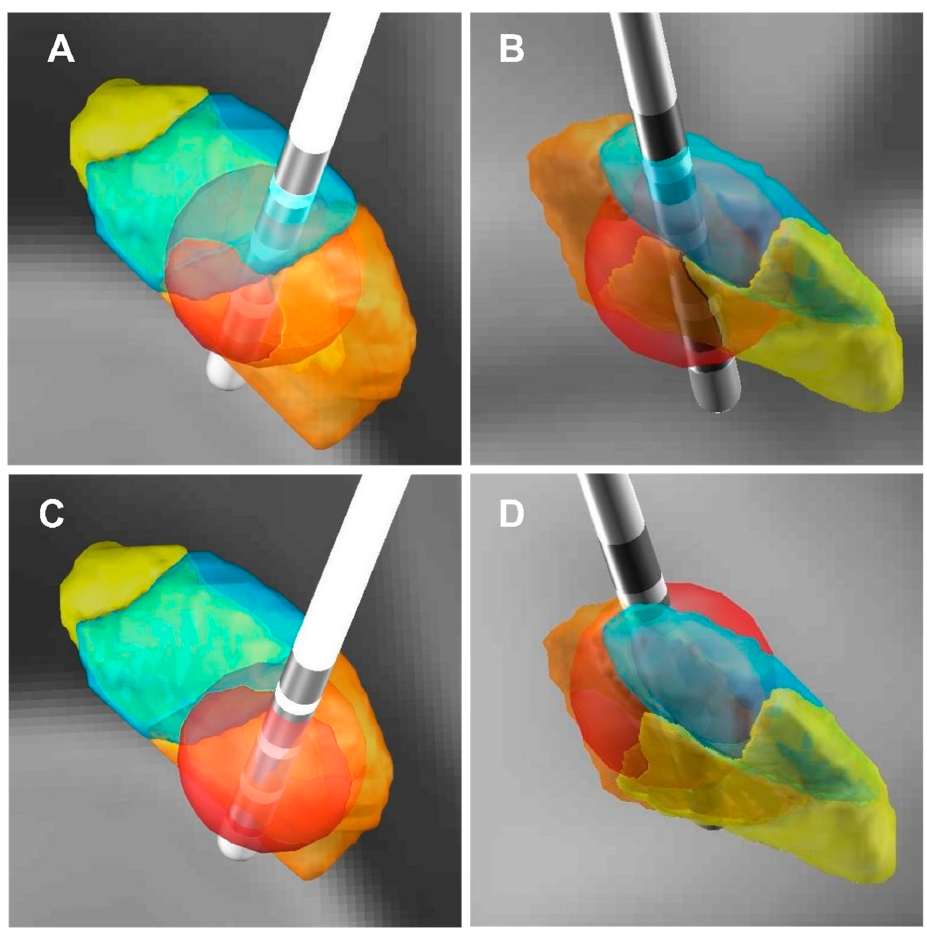
Figure 4. Three-dimensional illustration of VTA and its relationship with the improvement rate of the HAM-A scores. ( A , C ) Three-dimensional illustration of VTA (posterior view). ( B , D ) Three-dimensional illustration of VTA (front view). ( A , B ) The red dot patient (the HAM-A improvement rate: 87.50%), the VTA in the right STN limbic subregion in this patient was 19.29 mm 3 . ( C , D ) The blue dot patient (the HAM-A improvement rate: 9.09%), the VTA in the right STN limbic subregion in this patient was 3.01 mm 3 . (The red ball: VTA; The orange area: STN sensorimotor subregion; The blue area: STN associative subregion; The yellow area: STN limbic subregion).